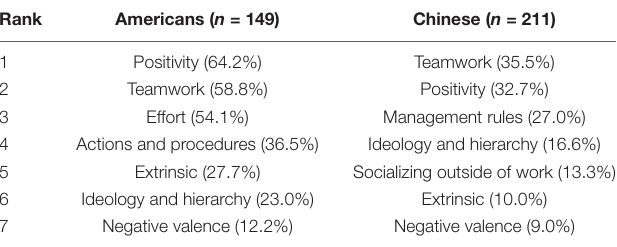
TABLE 2 | Frequency ranking of categories of associations with workplace participation generated by American and Chinese